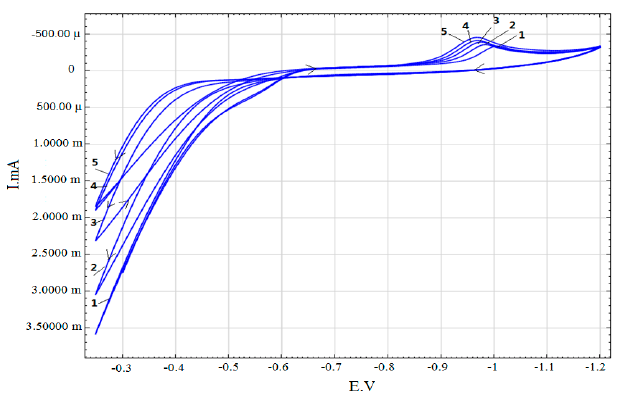
Figure 1. Cyclic volt–ampere curves of an iron electrode (cycles 1–5).